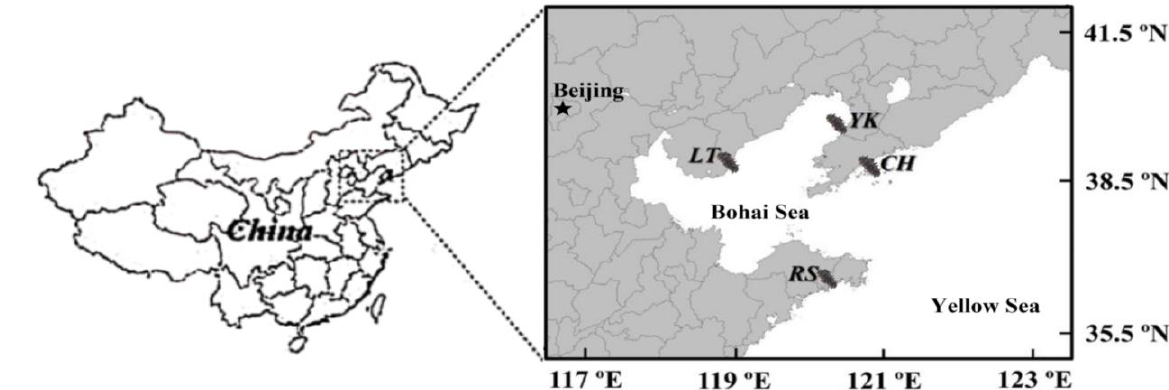
Figure 1. Sampling locations in four typical shore-based half-open Apostichopus japonicus culture ponds in northern China: Changhai (CH), Yingkou (YK), Laoting (LT), and Rushan (RS). Water (w), sediment (S), and the gut of A. japonicus (G) samples of culture